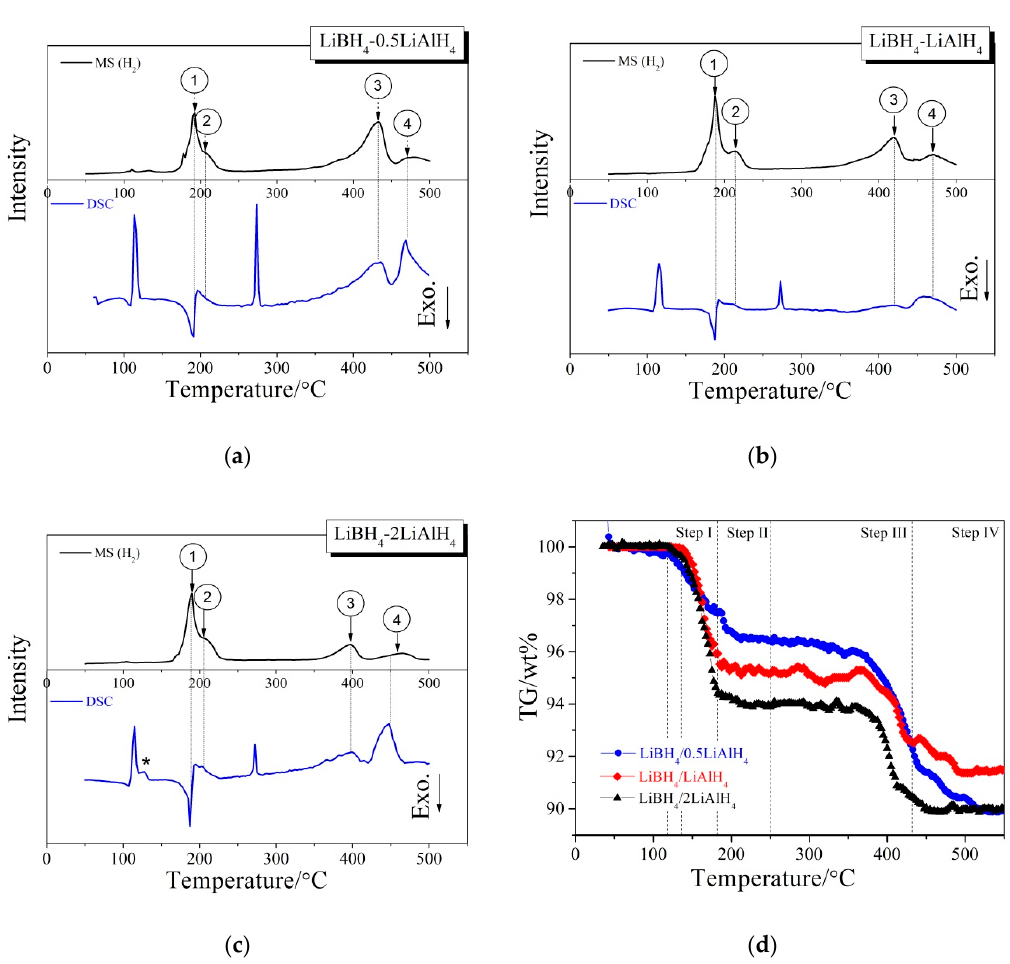
Figure 3. DSC / MS curves of the LiBH 4 / 0.5LiAlH 4 ( a ), LiBH 4 / LiAlH 4 ( b ), LiBH 4 / 2LiAlH 4 ( c ) and TG Figure 3. DSC/MS curves of the LiBH 4 /0.5LiAlH 4 ( a ), LiBH 4 /LiAlH 4 ( b ), LiBH 4 /2LiAlH 4 ( c ) and TG curves ( d ) of the LiBH 4 / x LiAlH 4 ( x = 0.5, 1, 2) curves ( d ) of the LiBH 4 / x LiAlH 4 ( x = 0.5, 1, 2) samples.